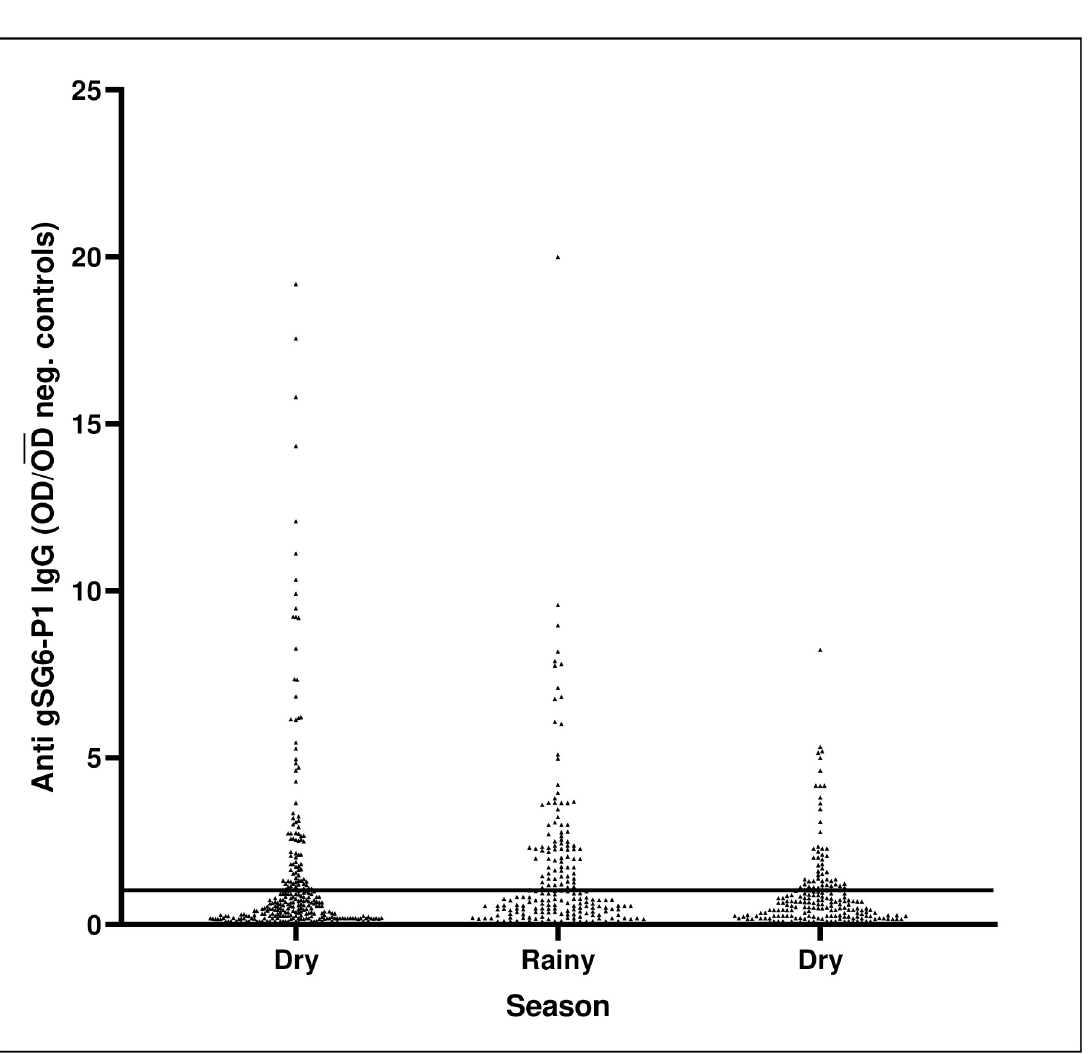
Fig 3. Individual anti-gSG6-P1 IgG levels measured during the dry season in March, rainy season in June and another dry season in September 2019; the bar at 1 shows the mean OD of negative